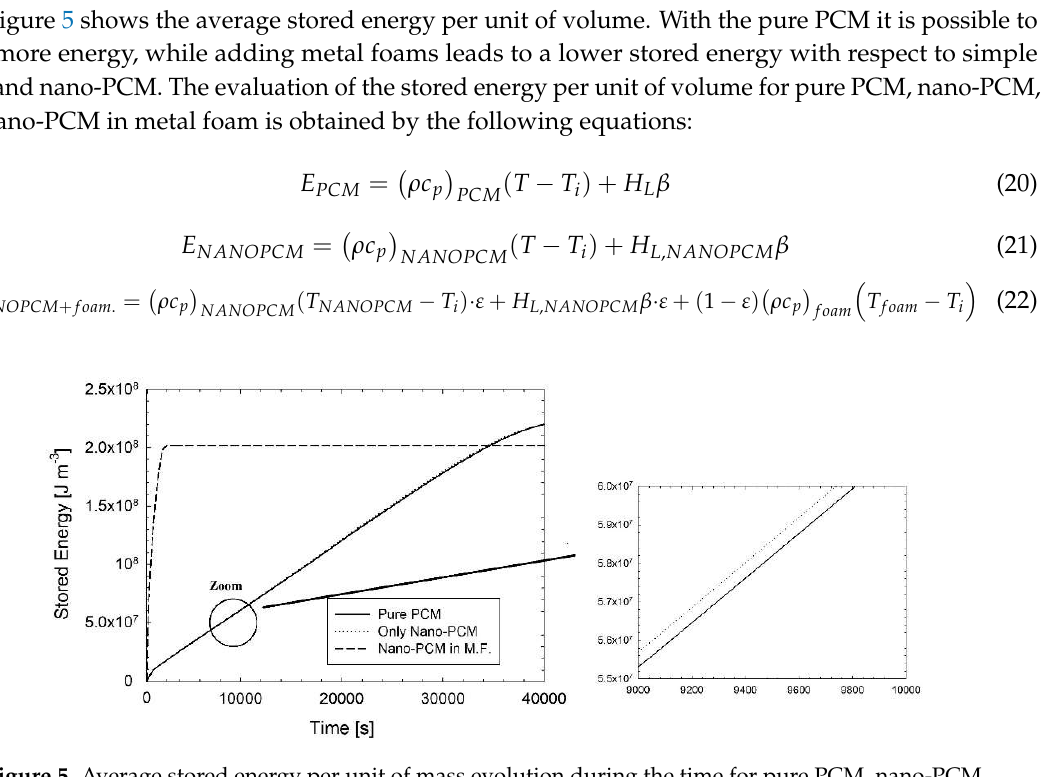
Figure 5. Average stored energy per unit of mass evolution during the time for pure PCM, nano-PCM, and nano-PCM in metal foam.